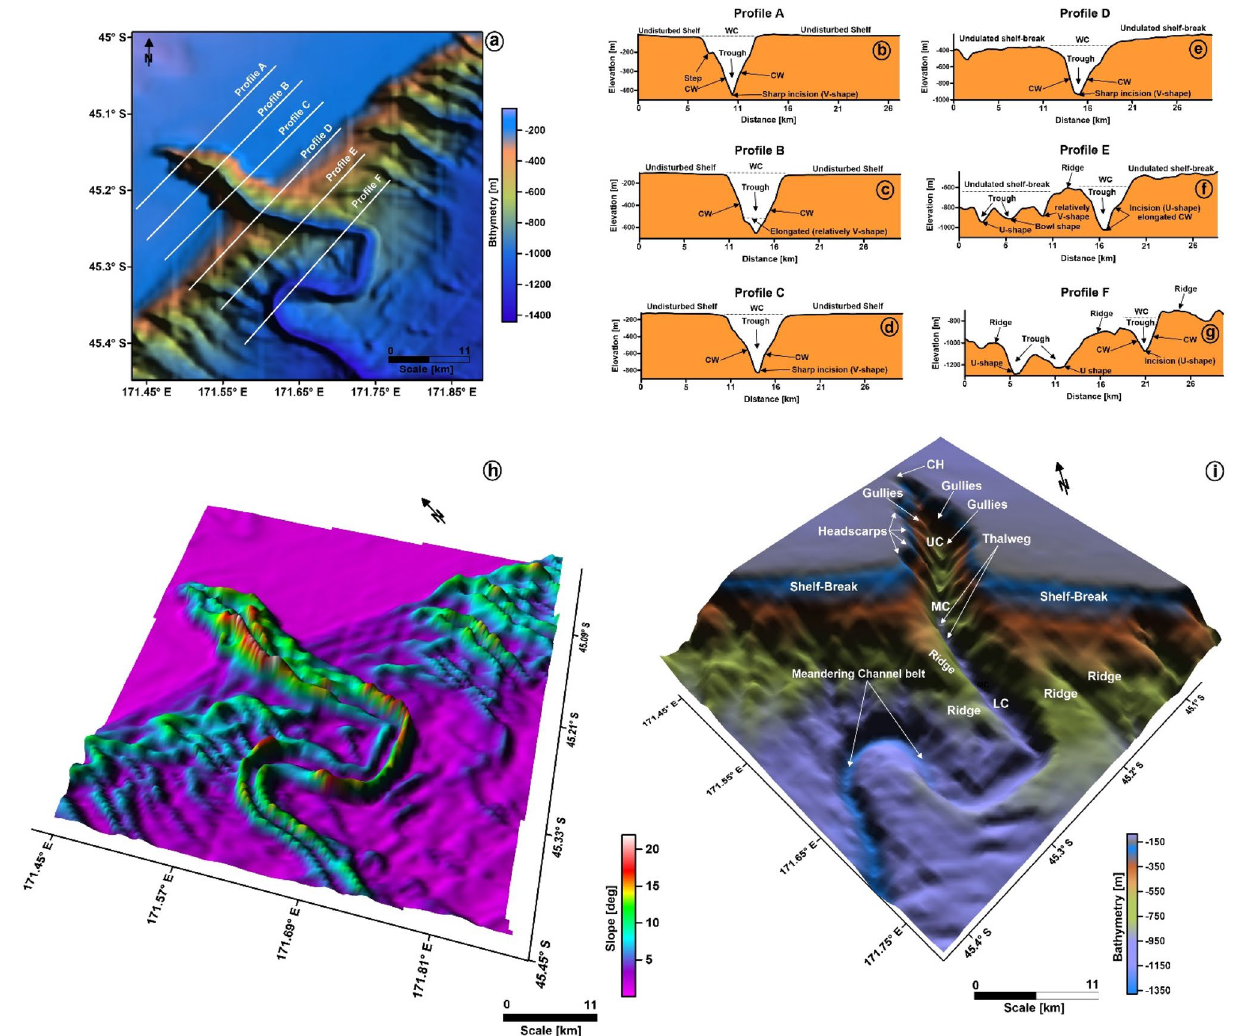
Figure 3. ( a ) Bathymetry map highlighting the geometry of the Waitaki Submarine Canyon at the shelf-break; ( b – g ) Profile cross-sections (A–F) along the dip of the canyon showing the nature of seafloor incisions made by the Waitaki Submarine Canyon at its upper course (Profiles A–C in b – d ), middle course (Profiles D–E in e , f ) and lower course (Profile F, in g ); ( h ) Slope gradient map of the canyon zone. The canyon contains steep- sided walls that are deeply incised into the shelf and slope of the Otago margin; ( i ) Physiography of the Waitaki Submarine Canyon showing different structural elements. The canyon consists of three structural domains: the Upper Course (UC), the Middle Course (MC) and the Lower Course (LC). The UC of the canyon contains the canyon head (CH), headscarps and gullies. The MC of the canyon contains the thalweg. The LC contains the ridges and meandering channel belts. These structural configurations make the canyon to have a V-shaped cross-section in the UC that slowly changes into a U-shape cross-section in the MC and LC. (The above maps are prepared using licensed version of Corel Draw v16 and OpendTect interpretation Suite